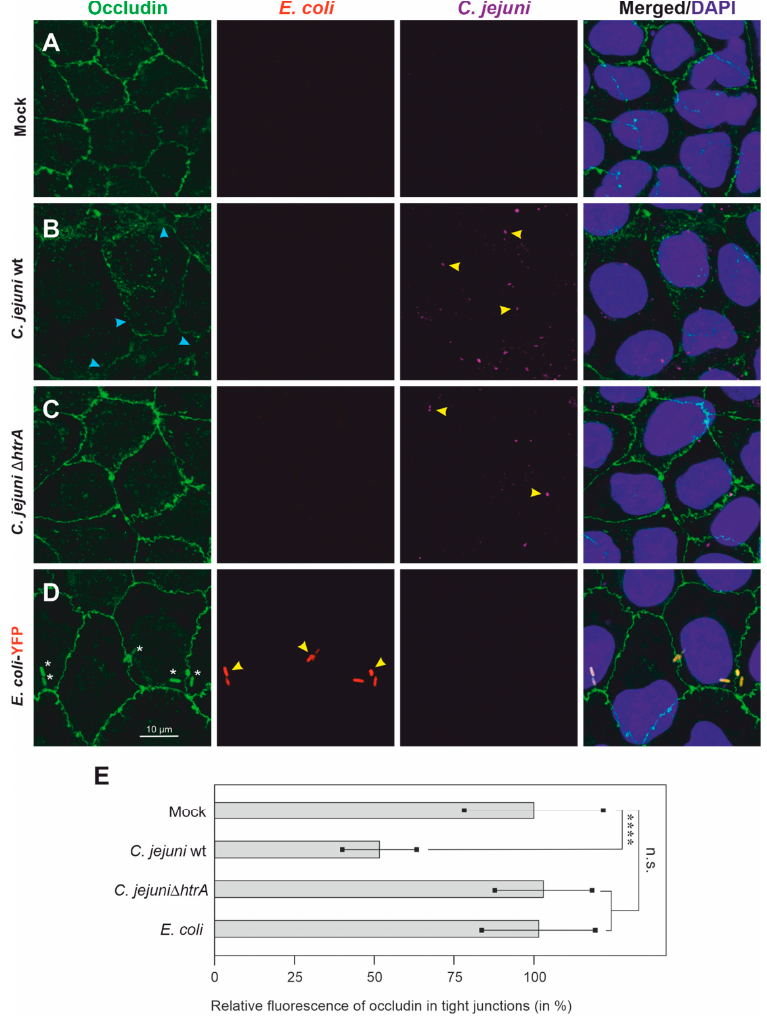
Figure 2. Top view of infected Caco-2 cells by immunofluorescence microscopy. Epithelial cell monolayers were left uninfected (Mock, A ) or were infected with either C. jejuni wt ( B ), C. jejuni ∆ htrA ( C ) or E. coli -YFP ( D ). After infection with an MOI of 10, the cells were immunostained using α -occludin and α - C. jejuni -specific antibodies as well as DAPI. Yellow arrowheads indicate bacterial cells interacting with Caco-2 cells at their apical surface and blue arrowheads show disrupted tight junctions. The white stars (panel D , left) indicate non-specific fluorescence signals from E. coli - YFP. ( E ) Relative fluorescence intensities of occludin in the tight junction areas were quantified and presented as the mean ± SD. The mean relative fluorescence of uninfected mock cells was set as 100%. Significant differences shown in the graphs correspond to p ≤ 0.0001 (****) or non-significant